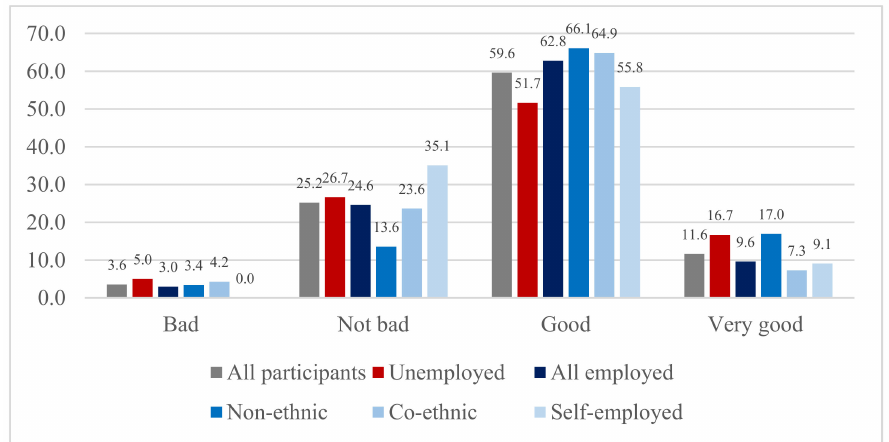
Figure 1. Self-rated Health by Employment Type (%).